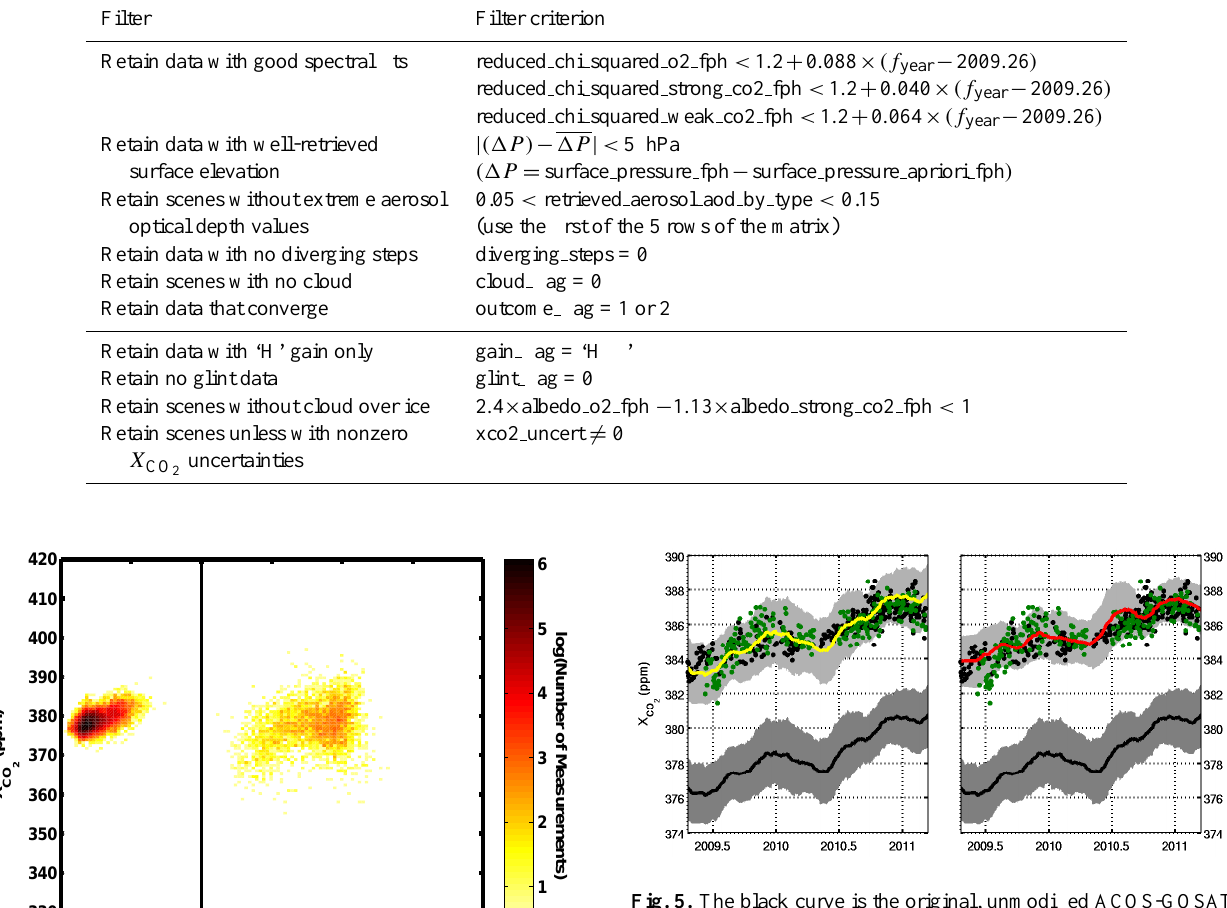
Fig. 5. The black curve is the original, unmodified ACOS-GOSAT data between 25 ◦ S and 55 ◦ S in both panels. The global bias (0.982) between the ACOS-GOSAT and TCCON data is removed in the left panel to obtain the yellow curve, and Eq. (4) is applied to obtain the red curve in the right panel. The grey shading represents 1 σ . The TCCON data from Lauder, New Zealand (black circles) and Wollongong, Australia (green circles) are plotted for compari-